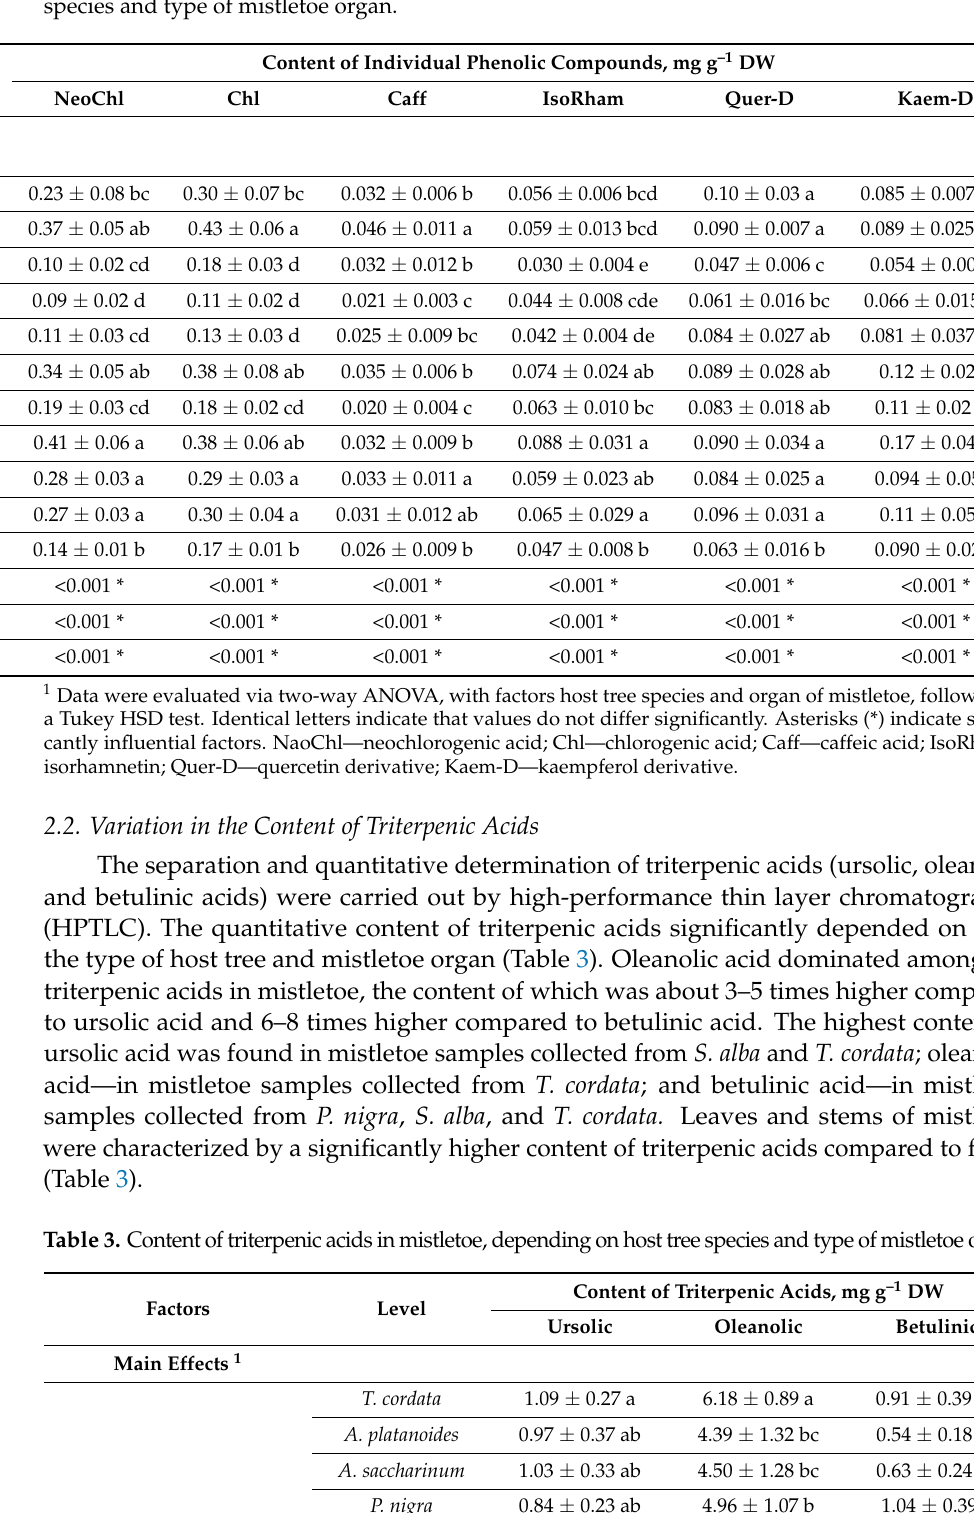
Table 2. Content of individual phenolic acids and flavonoids in mistletoe, depending on host tree species and type of mistletoe organ.